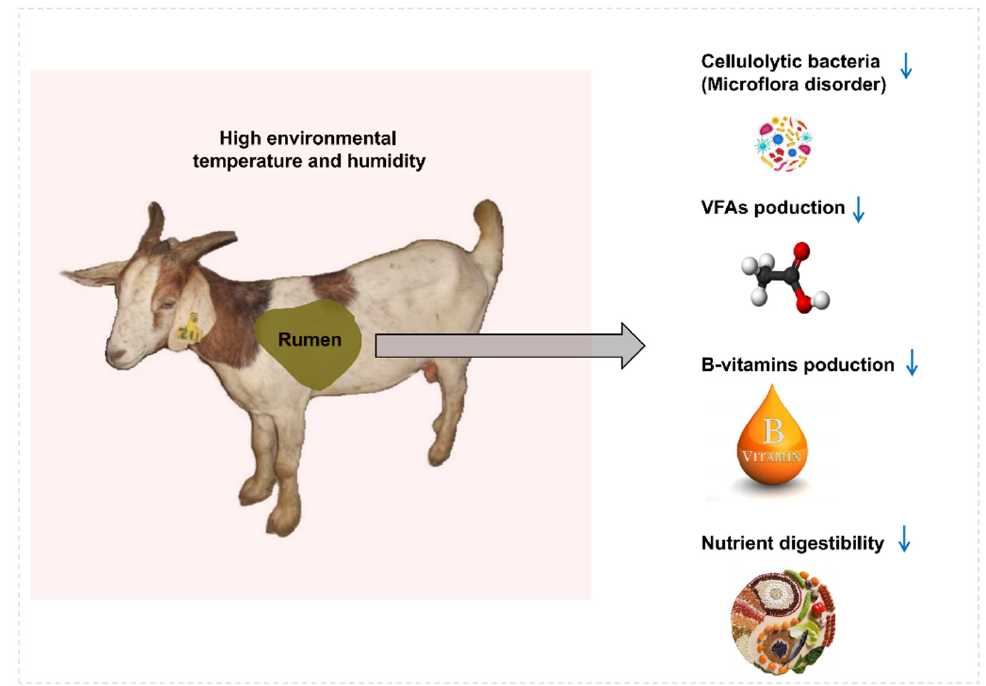
Figure 1. The adverse effects of hot summer on rumen fermentation and growth performance of goats. The blue arrow indicated a decrease.